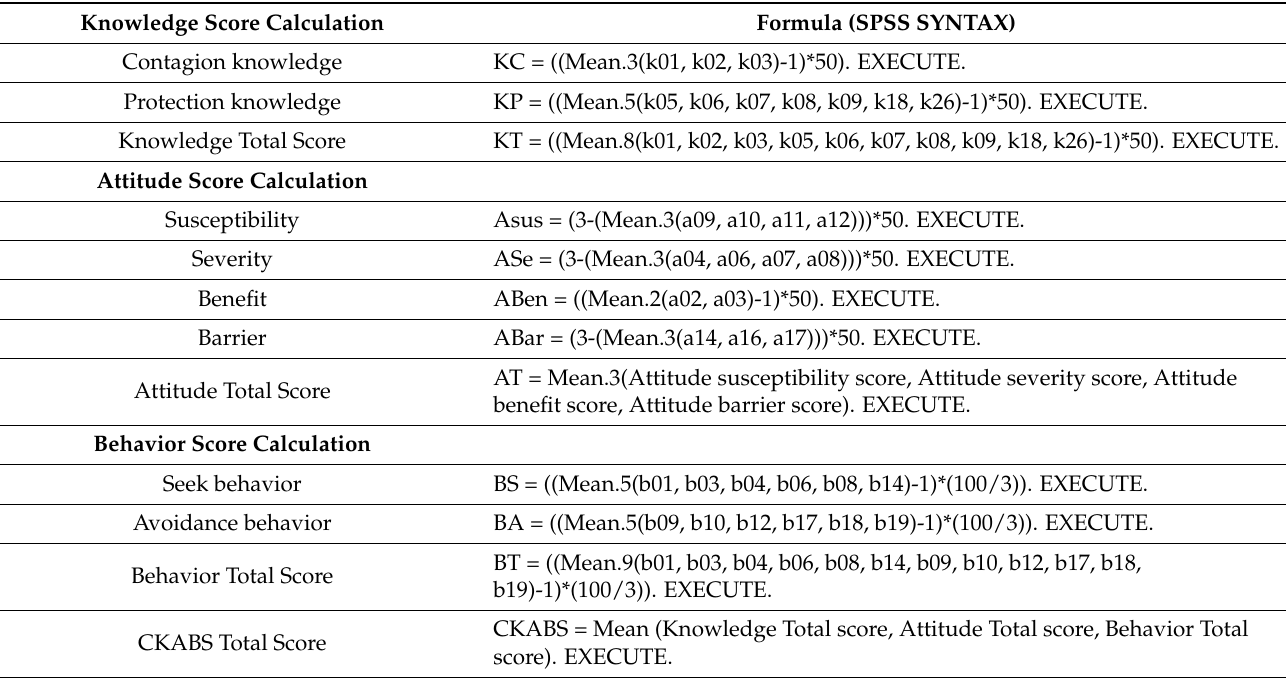
Table A1. COVID-19 Knowledge, Attitude, Behavior Score Calculation.